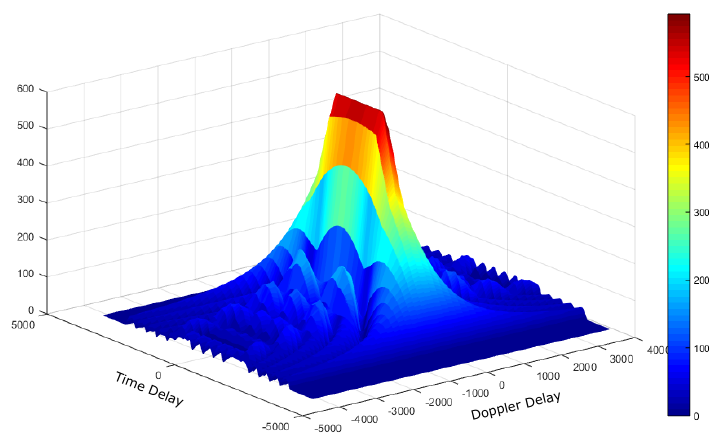
Figure 14. Two closer scatterers using square pulses, with no noise.